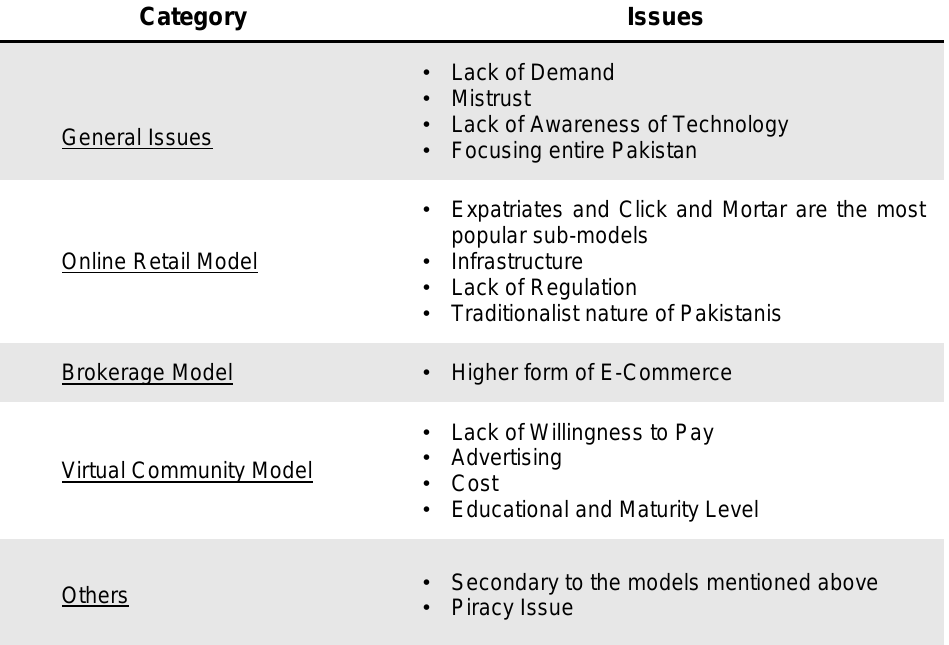
Table 1: Summary of the Issues faced in the Success of E-Commerce in